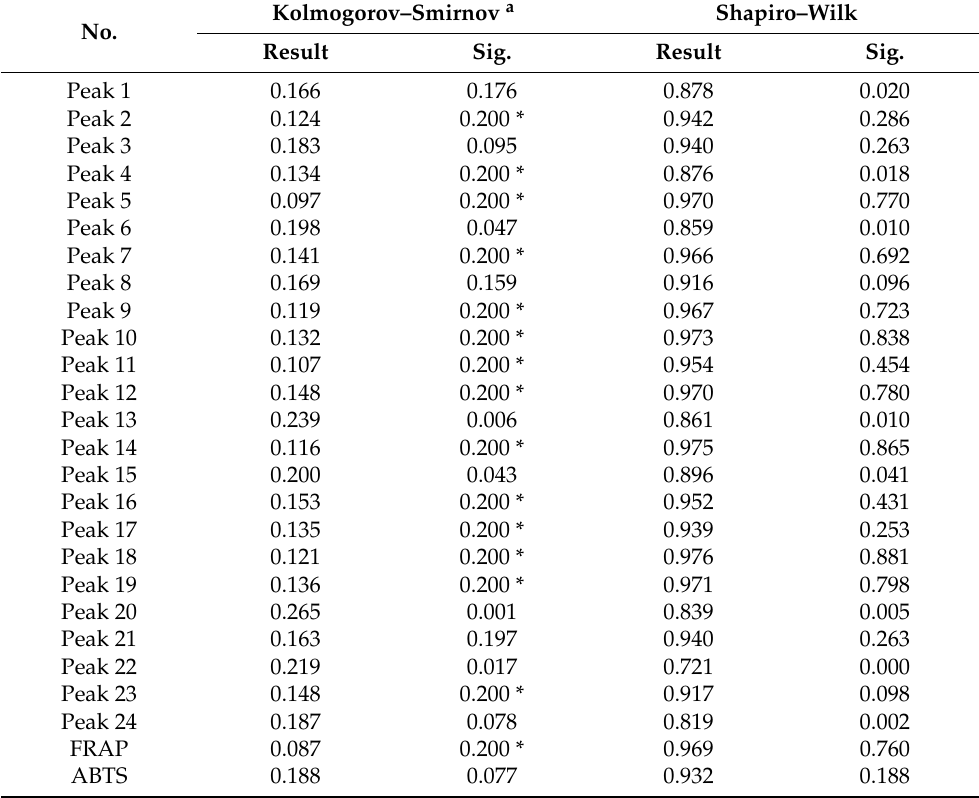
Table 3. Results of normality test.